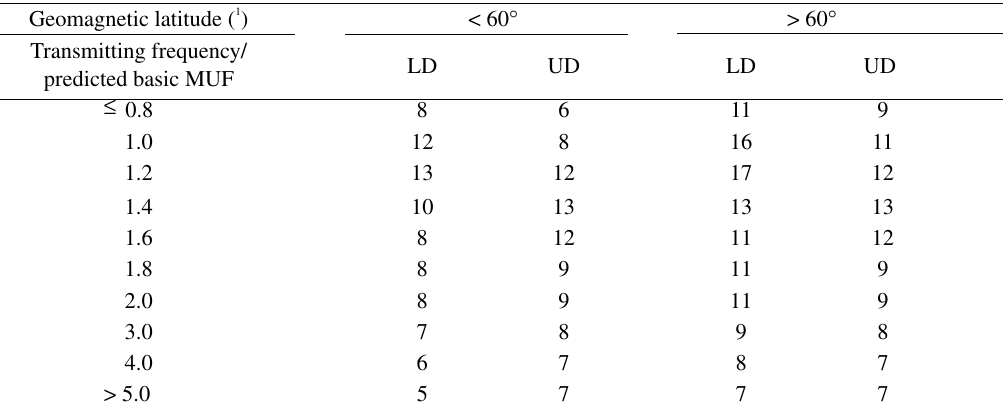
( 1 ) If any point on that part of the great circle which passes through the transmitter and the receiver and which lies between control points located 1000 km from each end of the path, reaches a geomagnetic latitude of 60 ° or more, the values of > 60 ° have to be